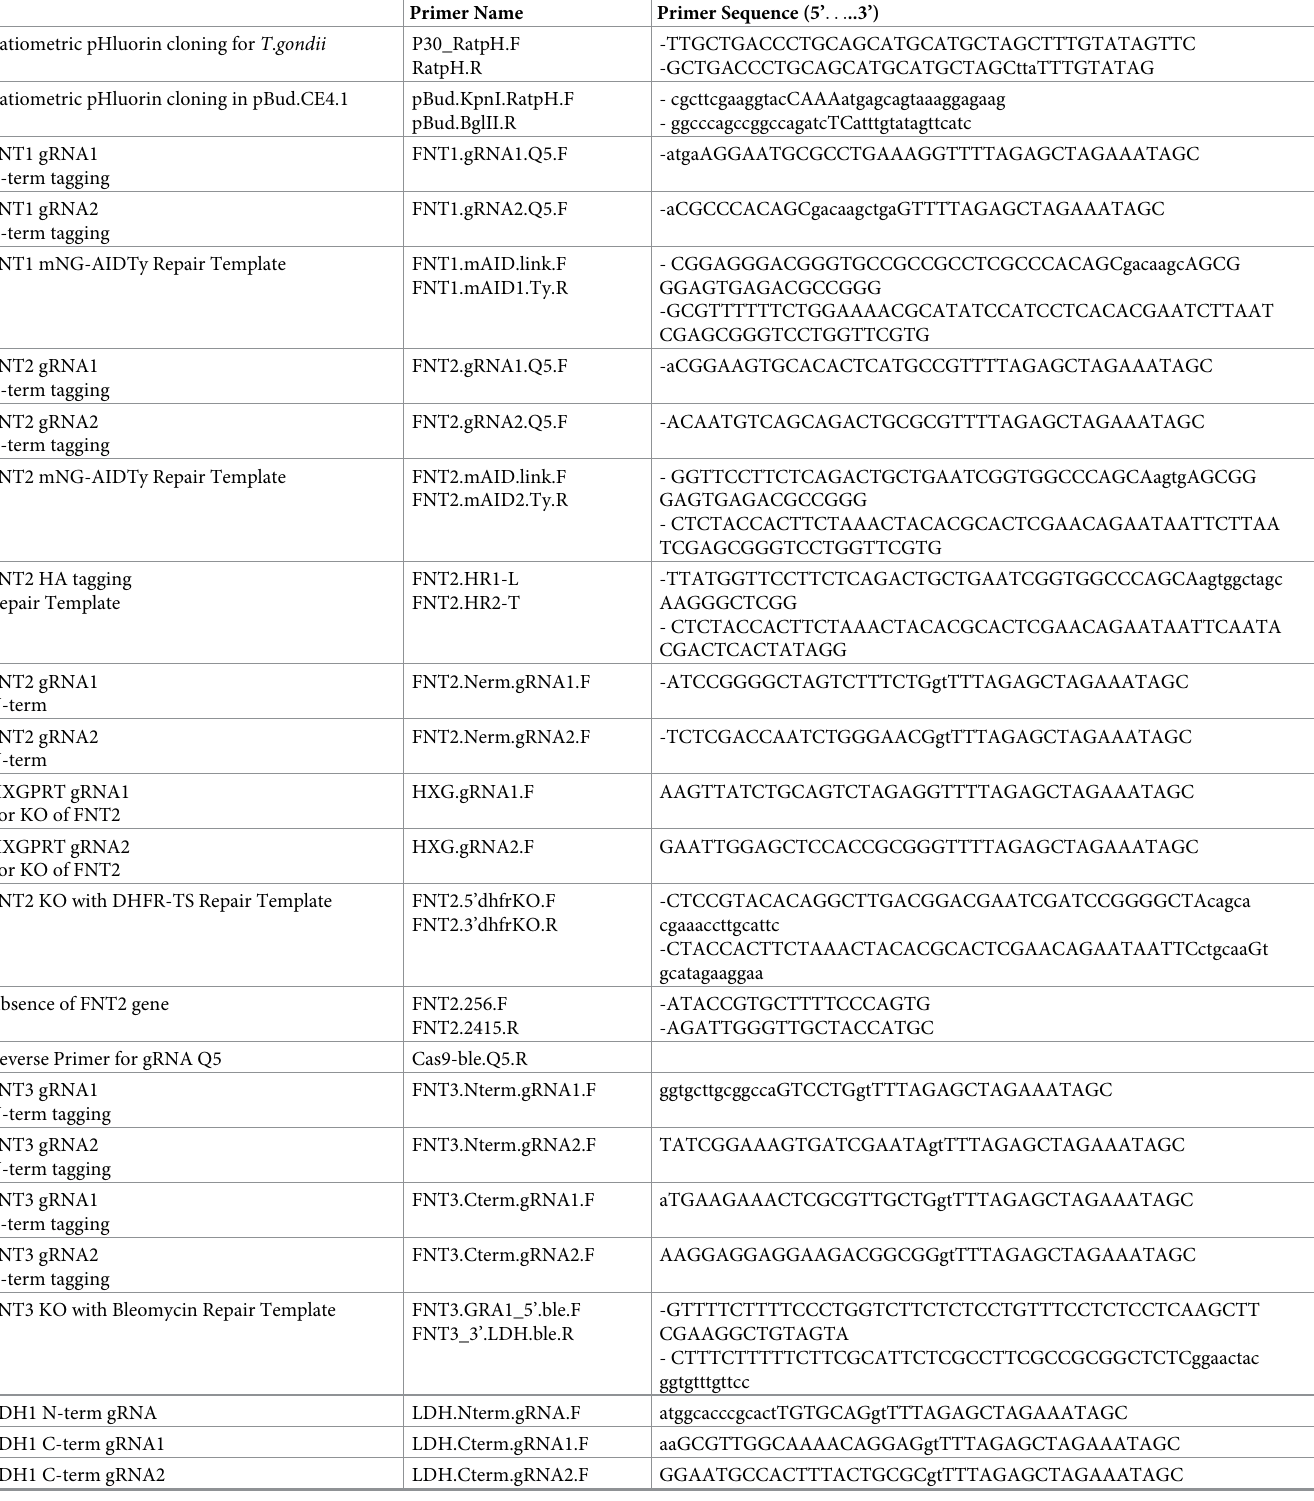
Table 2. Primers used in this